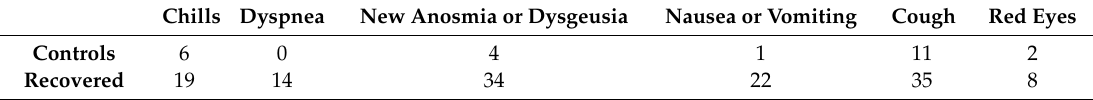
Table 6. Symptoms present in the cases and controls on the day of the interview.